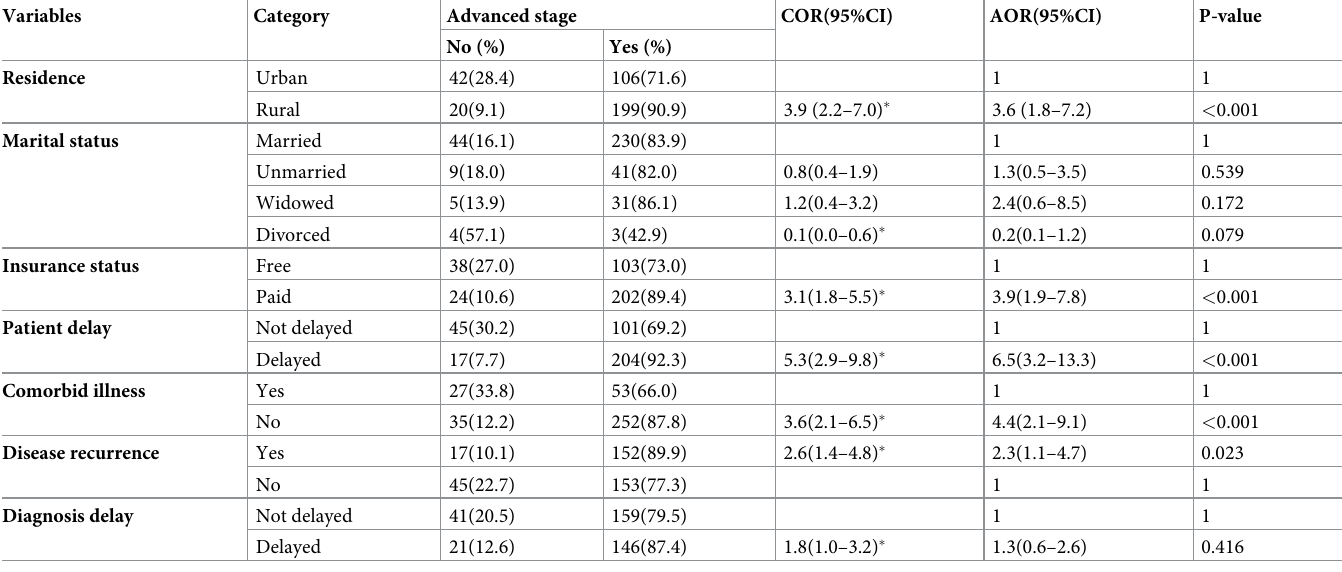
Table 3. Determinants of advanced stage presentation among colorectal cancer patients (n =